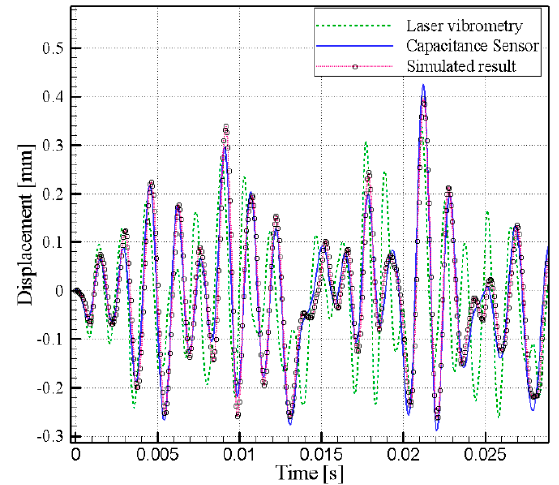
Figure 10. Comparison of displacement data simulated by the model and displacement measured by using the capacitance and laser displacement measurement systems.